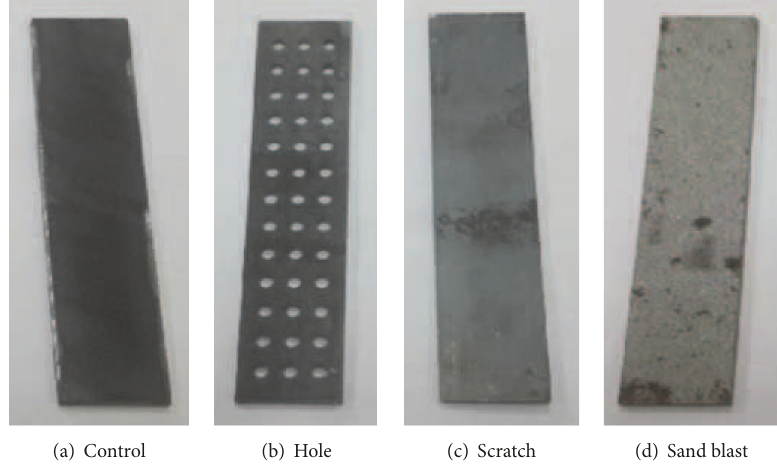
Figure 3: Surface geometry of steel panels.